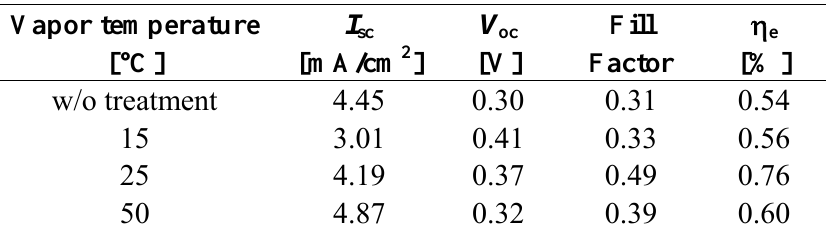
Table 2. Performance parameters in current-voltage characteristics of the solar cells under AM1.5 solar-illuminated conditions depending on vapor temperature at 21.6 vol % vapor concentration in the